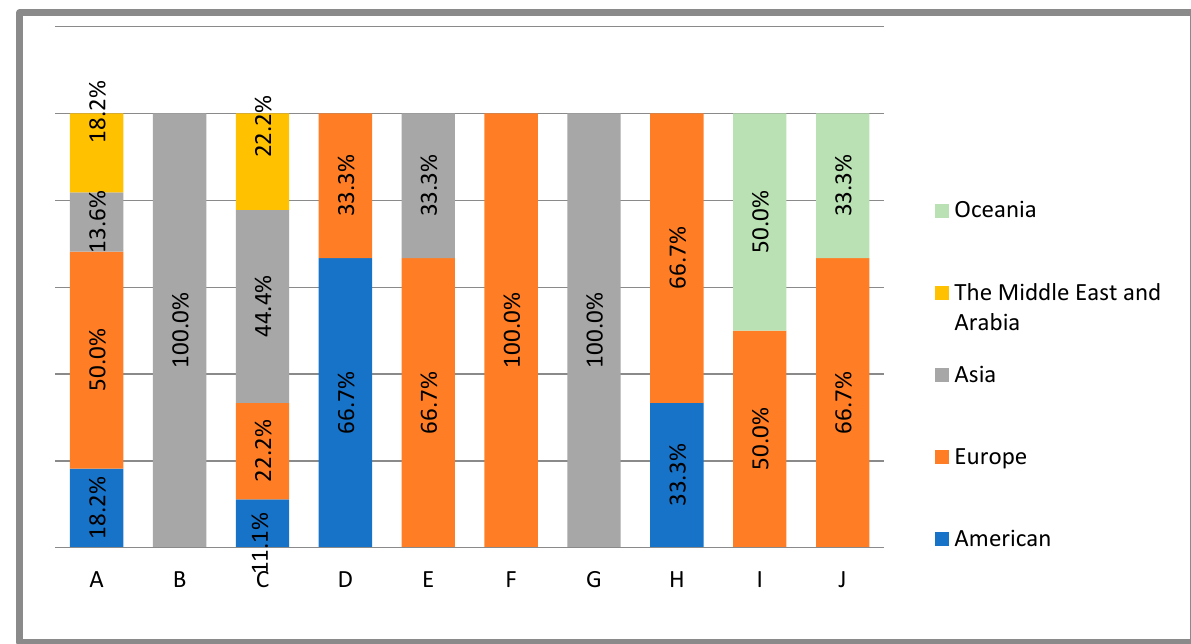
Figure 5. Clusters region distribution for January 2019 when N = 10 .